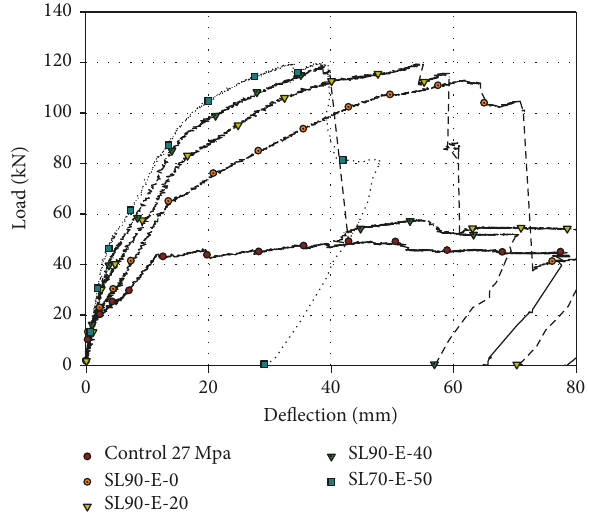
Figure 8: Experimental load-deflection curves.